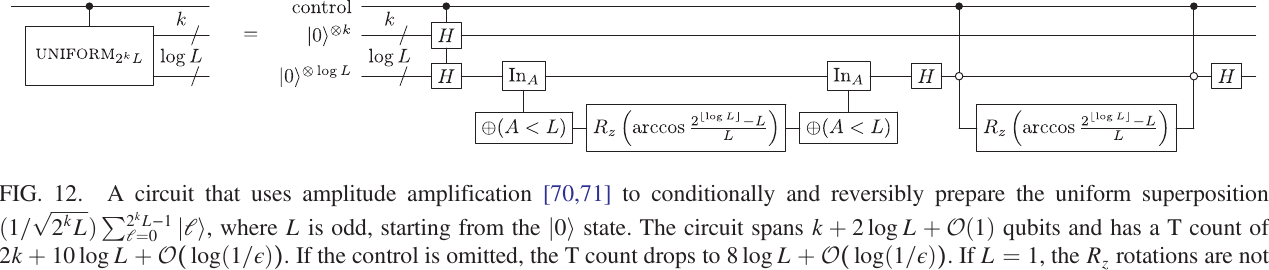
rotations are not z